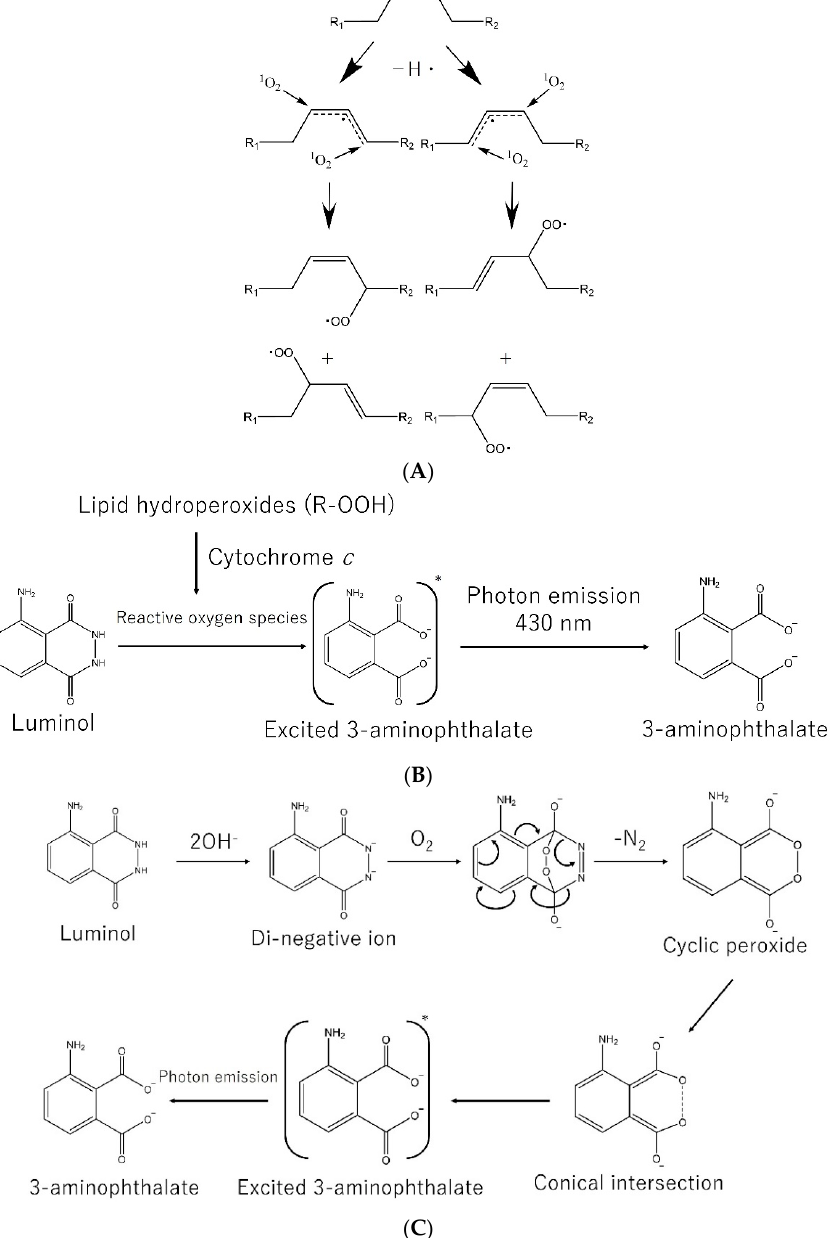
Figure 2. Free radical peroxidation of lipid by singlet oxygen ( A ) and chemiluminescence reaction of luminol with cyto- chrome c and lipid hydroperoxide ( B ) and proposed reaction scheme of luminol reaction ( C ). * indicates the excited state. Modified from [36,41,42] with permission from Elsevier and the American Chemical Society.